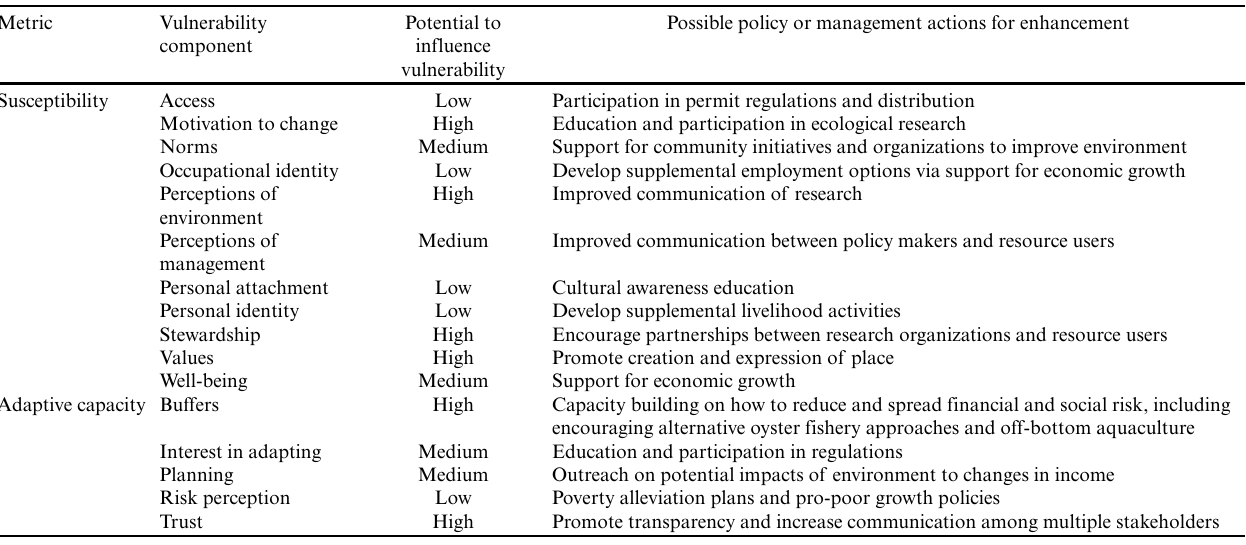
Table 5. Possible management and policy responses to influence different types of social vulnerability for the Louisiana oyster fishery. Potential to influence vulnerability is derived from the factor scores.